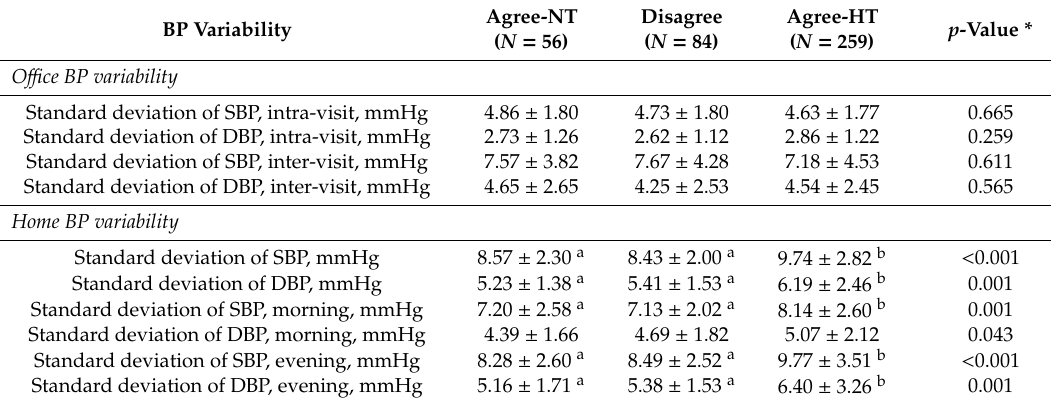
Table 5. Comparisons of the blood pressure